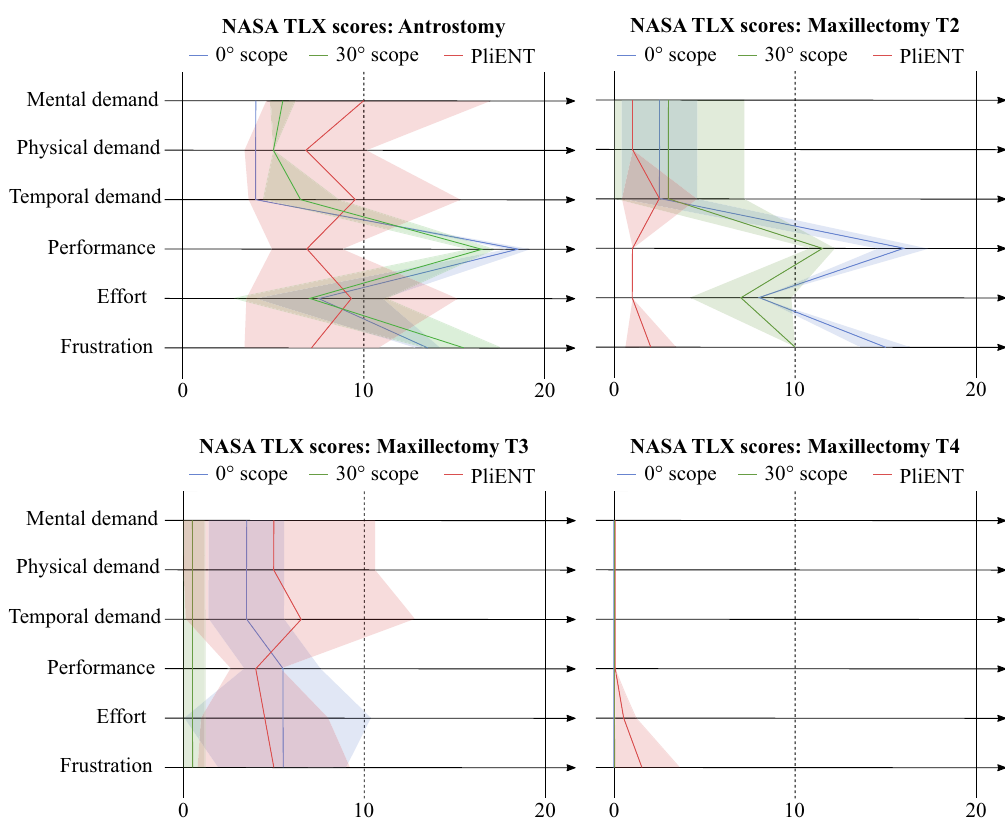
Figure 5. Results of the NASA-TLX test for the 0° (blue) and 30° (green) rigid endoscopes and the PliENT endoscope (red) for each of the considered enlargement procedures. The mean score is indicated with a thick line, whereas the standard deviation is indicated with a transparent surface